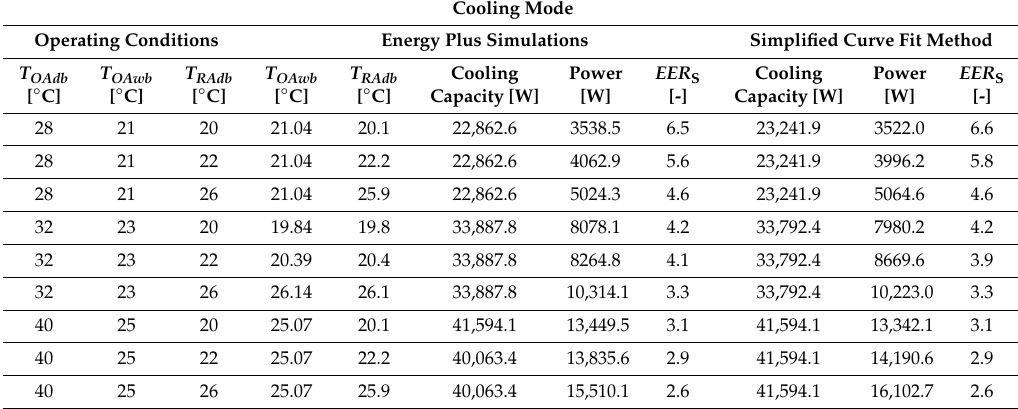
Table A3. Benchmark simulations for the air-to-air heat pump (cooling